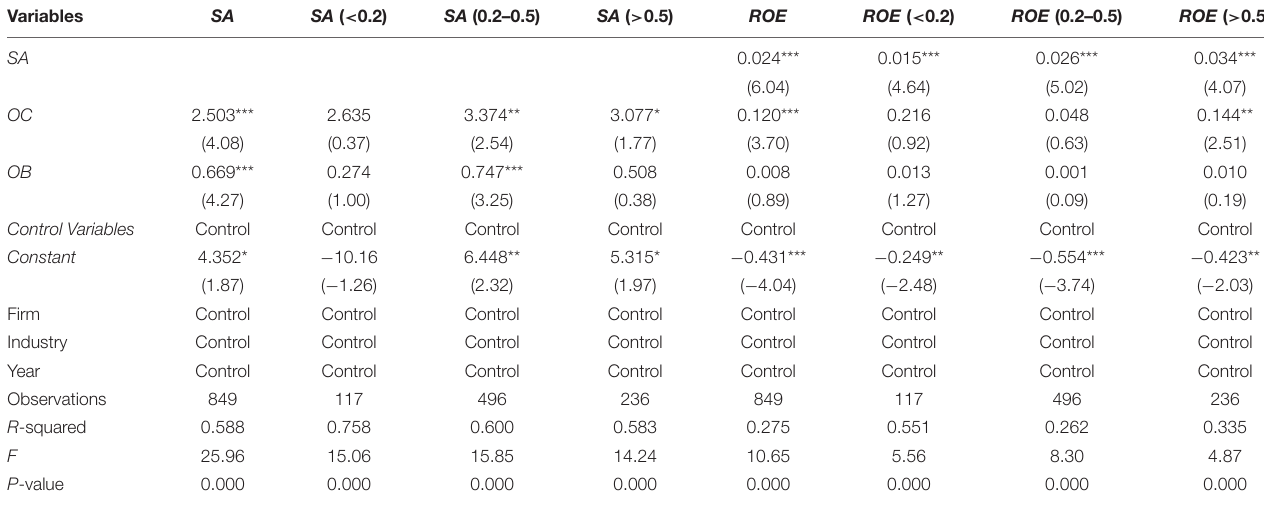
TABLE 5 | Models (1) and (2): multiple regression results.